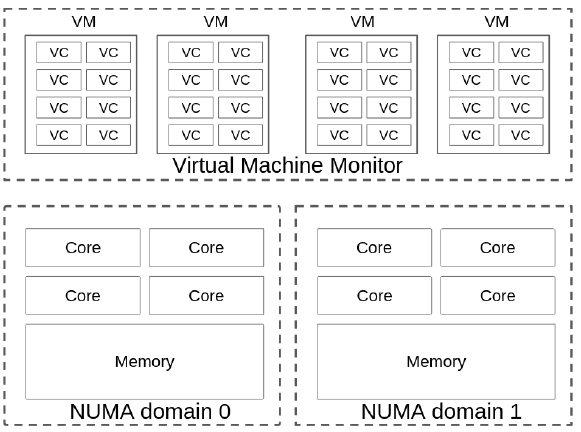
Figure 2. Mapping 32 virtual cores to eight physical cores on two NUMA